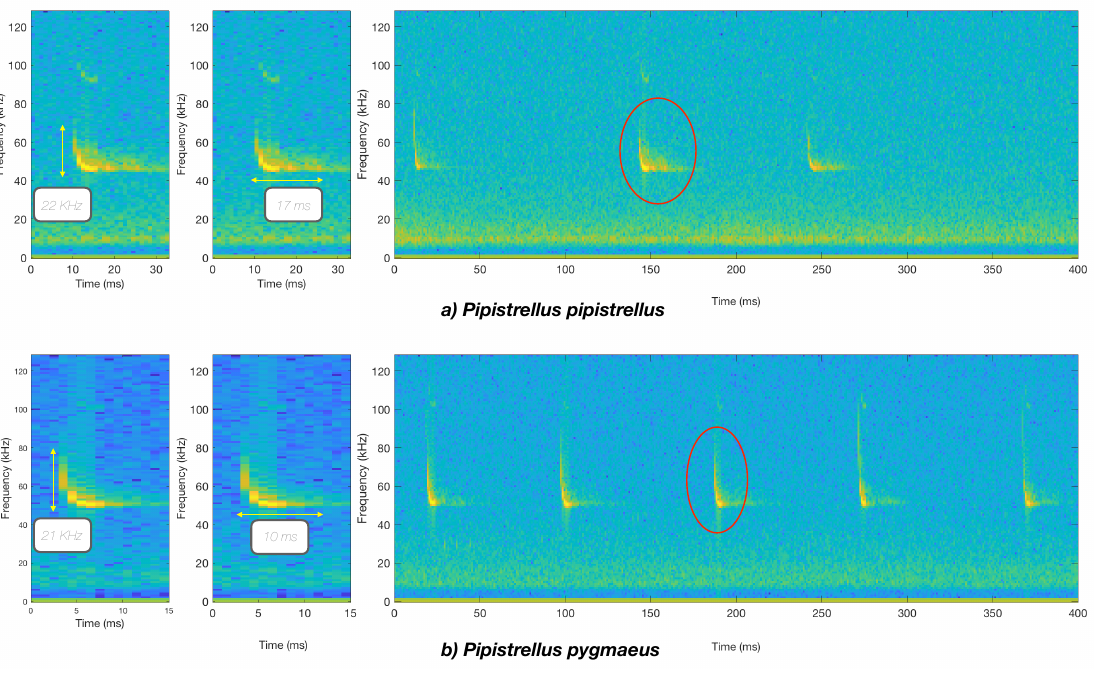
Figure 4. Spectrograms of the species. The left hand figures illustrate a close view of the call pulse and the measurement of its bandwidth and duration (85 Power/Frequency). The right hand figures, represents 400 ms’ of an audio fragment containing a bat